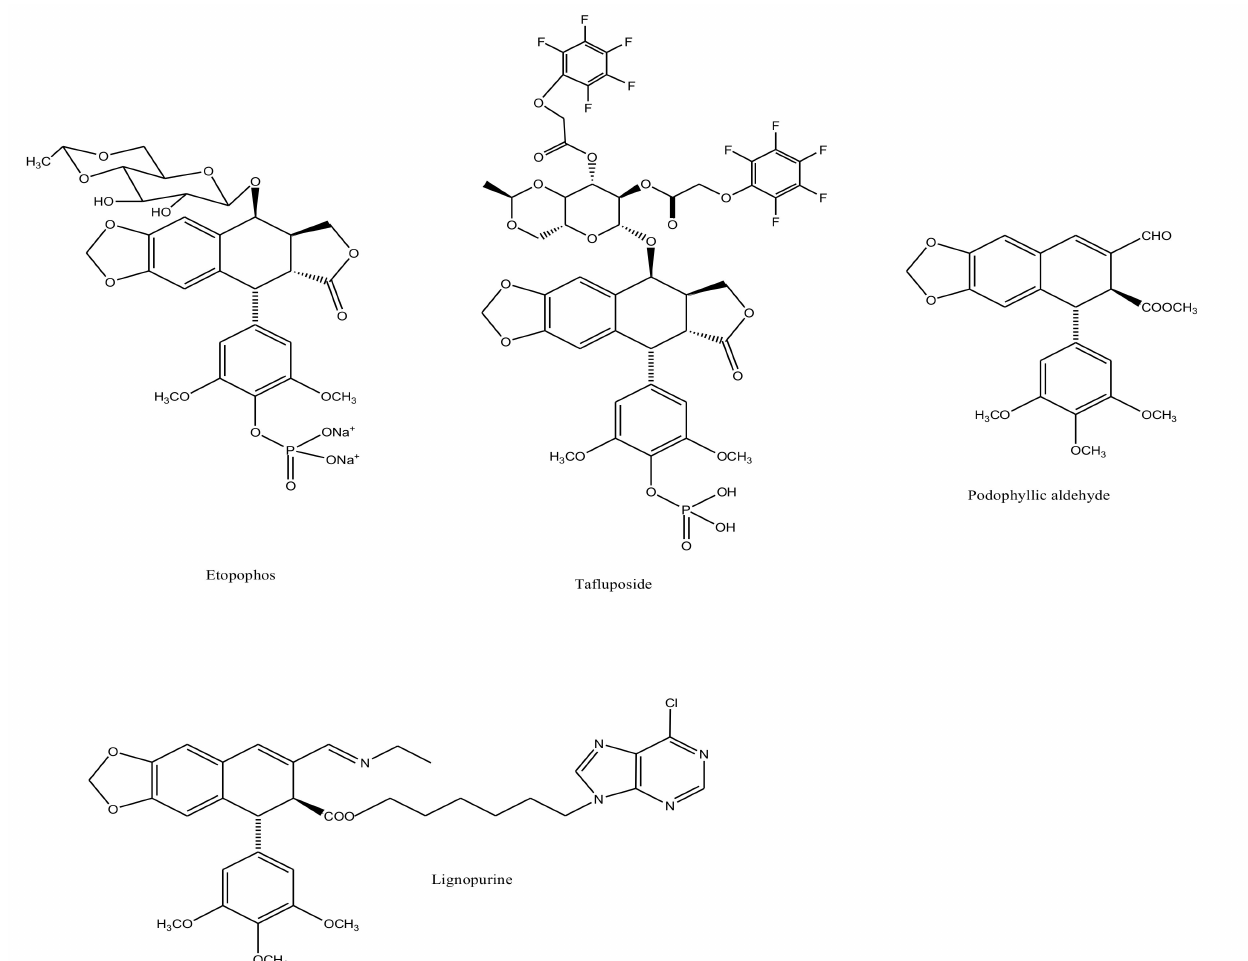
Figure 7. The figure shows structural illustrations of E-ring modified derivatives much of which have proved to be clinically